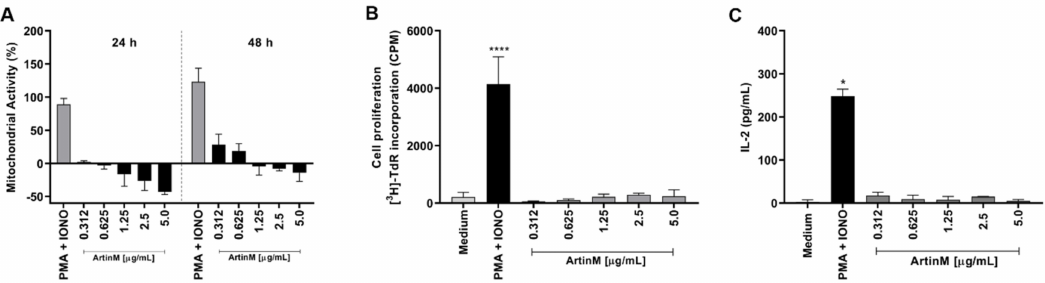
Figure 1. Increased mitochondrial activity of murine B cells induced by ArtinM is not accompanied by B cell proliferation or IL-2 production. B cells were purified from a spleen cell suspension obtained from C57BL/6 mice, seeded in 96-well microplates (5 × 10 5 cells/well), and incubated with ArtinM at different concentrations ( A – C ). A mixture of Phorbol-12-myristate-13-acetate (PMA; 50 ng/mL) and Ionomycin (IONO; 1 µ M) was used as a positive control for cell activation, and medium alone was used as a negative control (Medium). ( A ) Following 24 or 48 h incubation with ArtinM, 3-(4,5- dimethyl-2-thiazolyl)-2,5-diphenyl-2H-tetrazolium bromide (MTT; 50 µ g/mL) was added to the